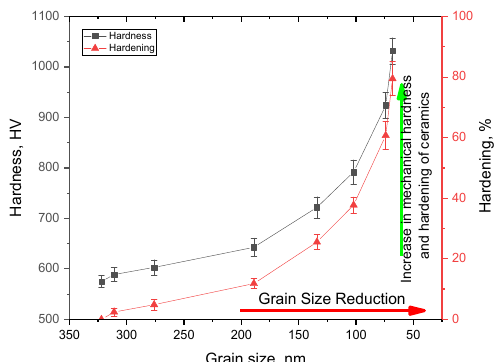
Figure 6. Results of changes in hardness and hardening of ceramics with a decrease in the grain size.